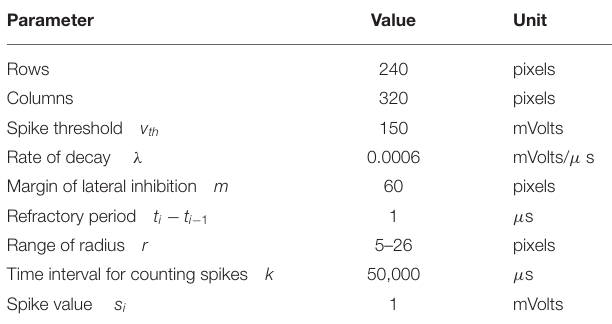
TABLE 1 | The parameters of pseudo-frame gradient Hough circle transform.